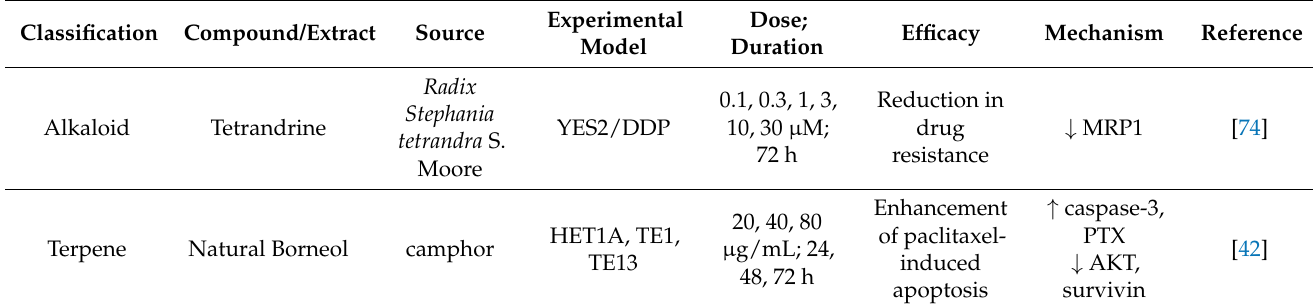
Table 4. Anti-resistance-related natural products.